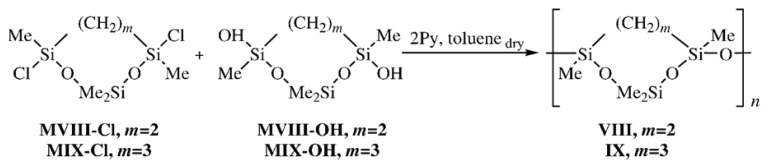
Synthesis of CL PMCS VIII, IX.